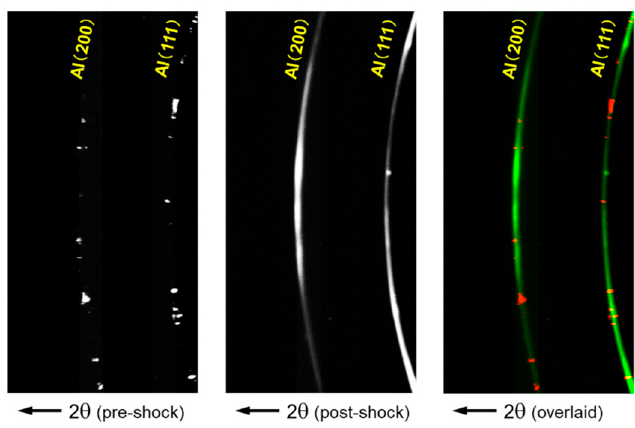
Figure 17. Diffraction pattern of the solution heat-treated A6061 aluminum alloy. The spotty pattern prior to laser irradiation (pre-shock) changed to a quasi-ring pattern (post-shock).